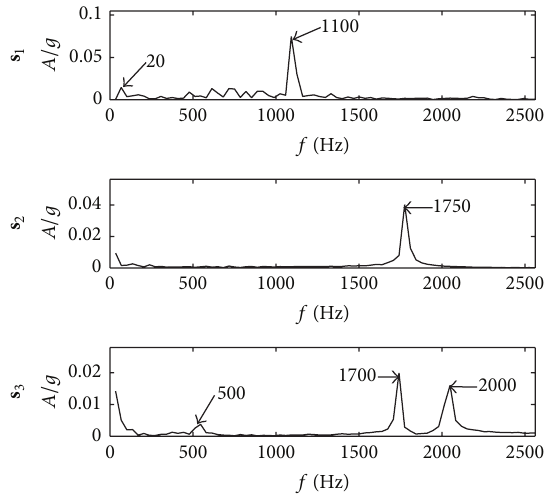
Figure 11: Spectrums of the source